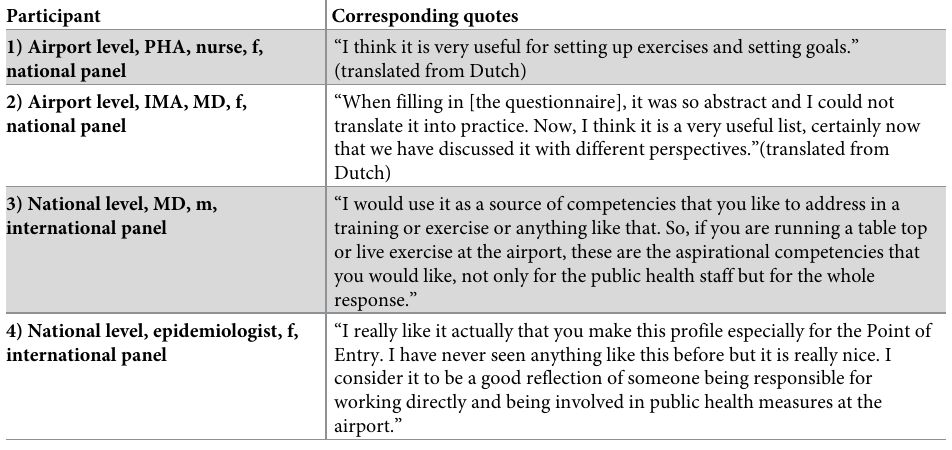
Table 3. Quotes of consensus meeting participants regarding the usability level of the refined competency